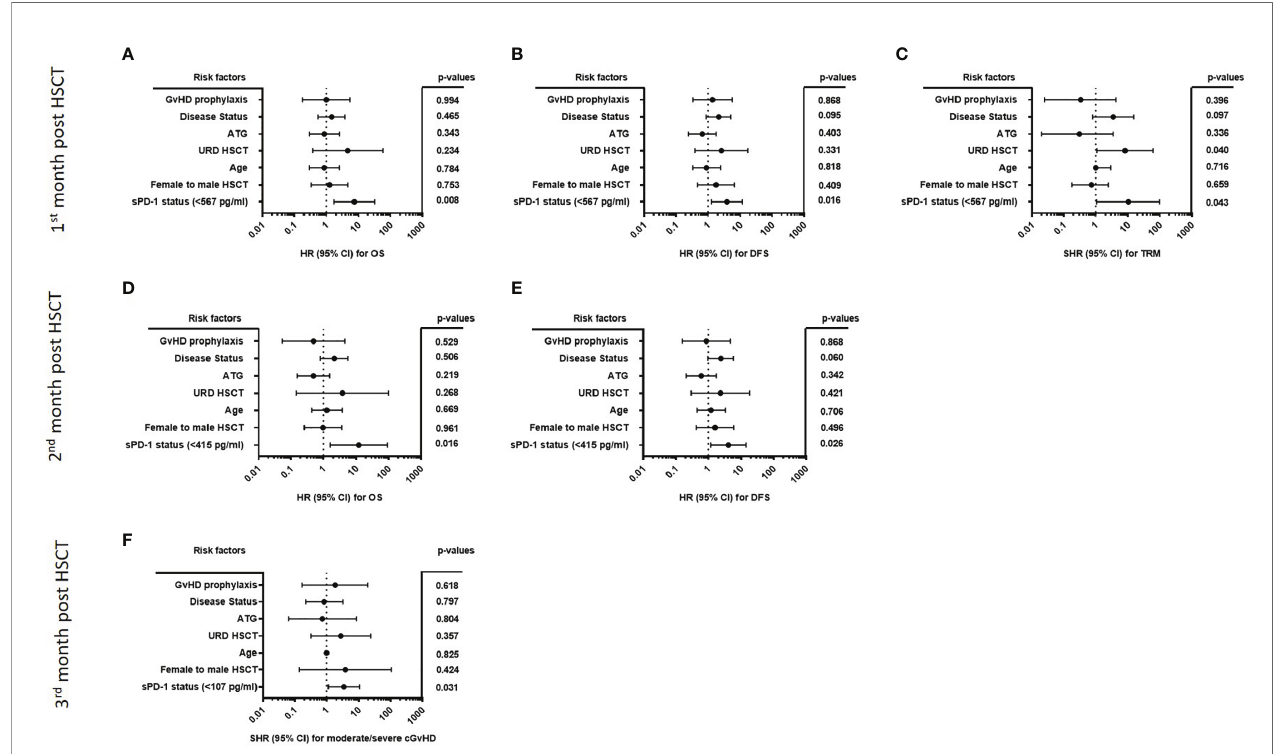
FIGURE 8 | Forest plot of risk factors for moderate/severe cGvHD, OS, DFS, and TRM post HSCT. The forest plots visualize the multivariate analyses of the following parameters for OS (A, D) , DFS (B, E) TRM with relapse as competing event (C) and moderate/severe cGvHD with aGvHD grade III-IV as competing event (F) : disease status (early/intermediate versus late), ATG-treatment (yes versus no), age at time of HSCT, URD-HSCT (yes versus no), female donor to male patient HSCT (yes versus no), GvHD prophylaxis (CSA & MTX versus CNI & MMF), and the sPD-1 status using the different cut-off levels. For OS, DFS, and TRM a cut-off of sPD-1 < 567 pg/ml of one month (A – C) , and a cut-off of sPD-1< 415 pg/ml two months post HSCT (D, E) were used, while for moderate/severe cGvHD a cut-off of sPD-1 < 107 pg/ml three months post HSCT was used. Due to death or loss of follow up, data were available for 74 (A – C) , 69 (D, E) , and 67 (F) out of 82 patients; 95% CI, 95% con fi dence interval; HR, hazard ratio; SHR, Subhazard